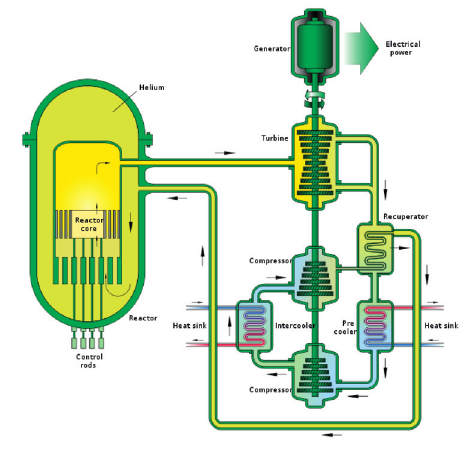
Fig. 12. 4 th generation reactor for